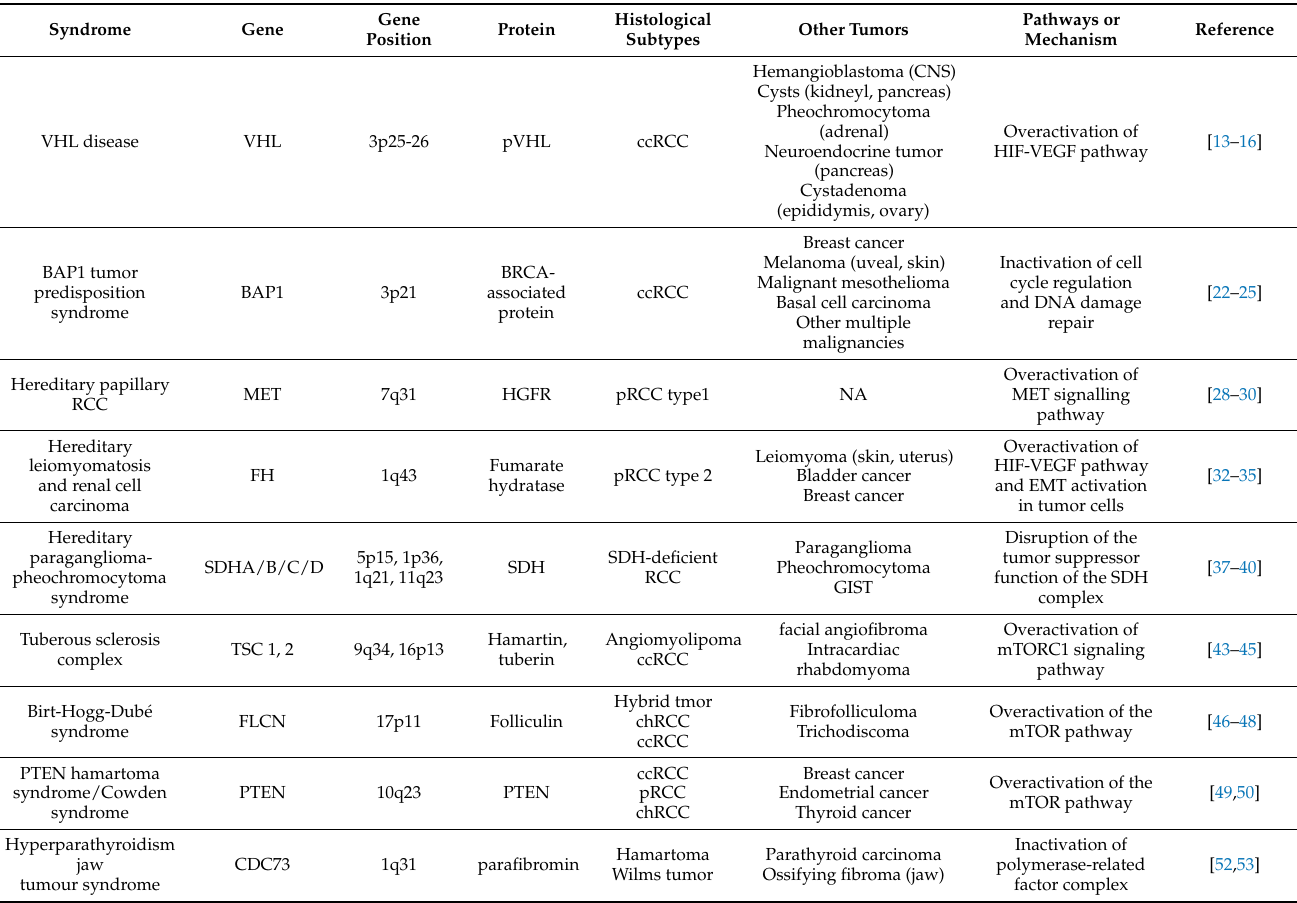
Table 1. RCC-associated hereditary